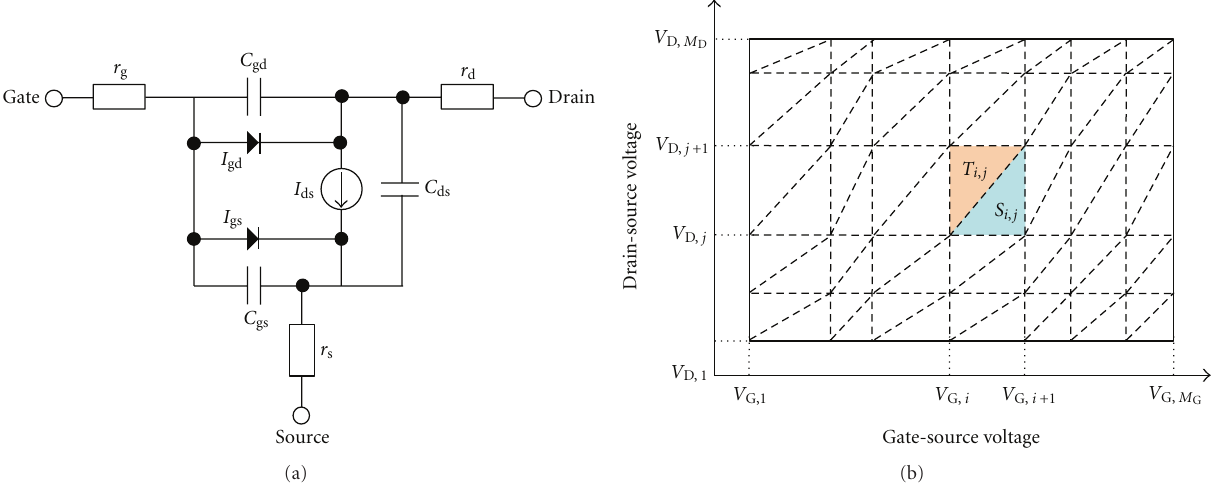
Figure 1: FET model in FDTD. (a) The Statz model and (b) A triangulation of V GS − V DS